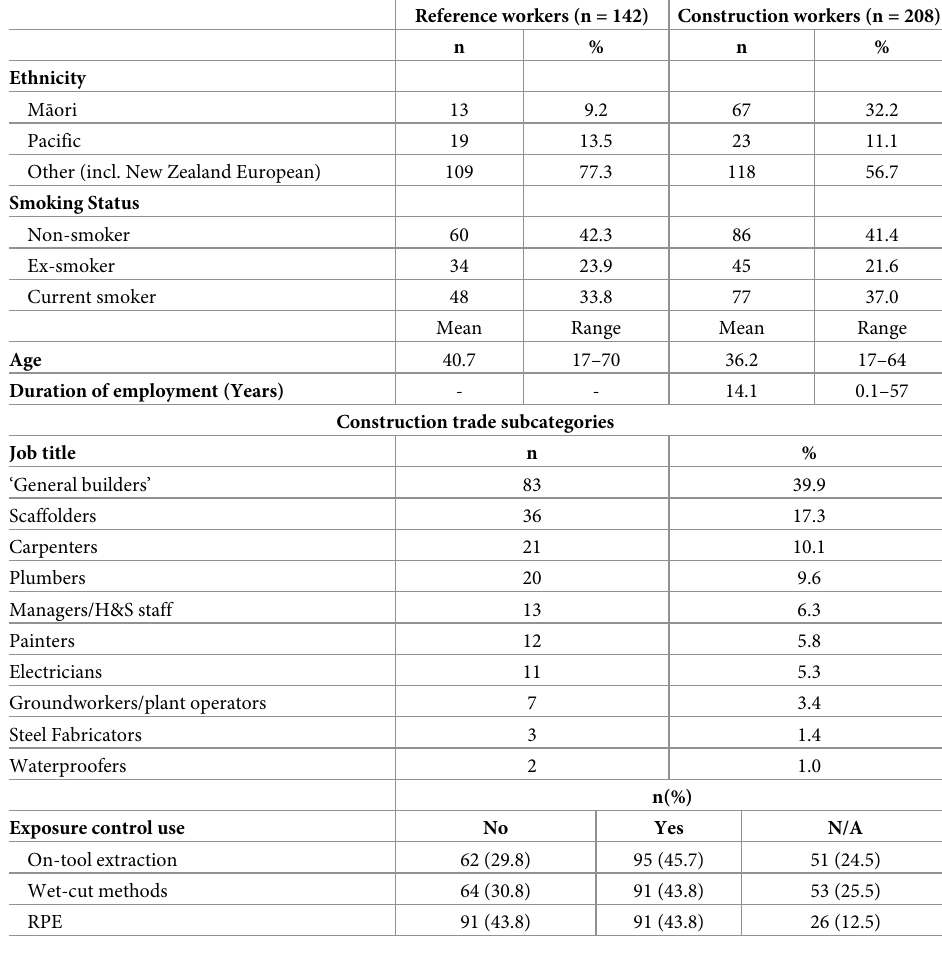
Table 1. Participant